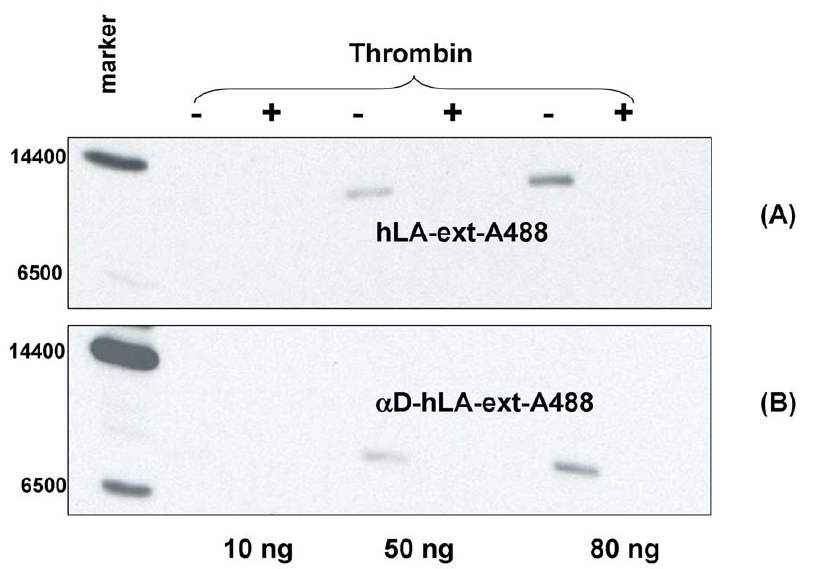
Figure 5. Site-specific labeling of proteins with aminooxy-biotin. Glycosylated proteins of hLA-ext (A) and a D-hLA-ext (B) were coupled with aminooxy-biotin. Proteins were separated on SDS- PAGE and transferred to the nitrocellulose membrane. Biotinylated proteins were detected with streptavidin-HRP and chemiluminescent substrate. Biotinylated HAMLET retained cytotoxic activity (data not shown).